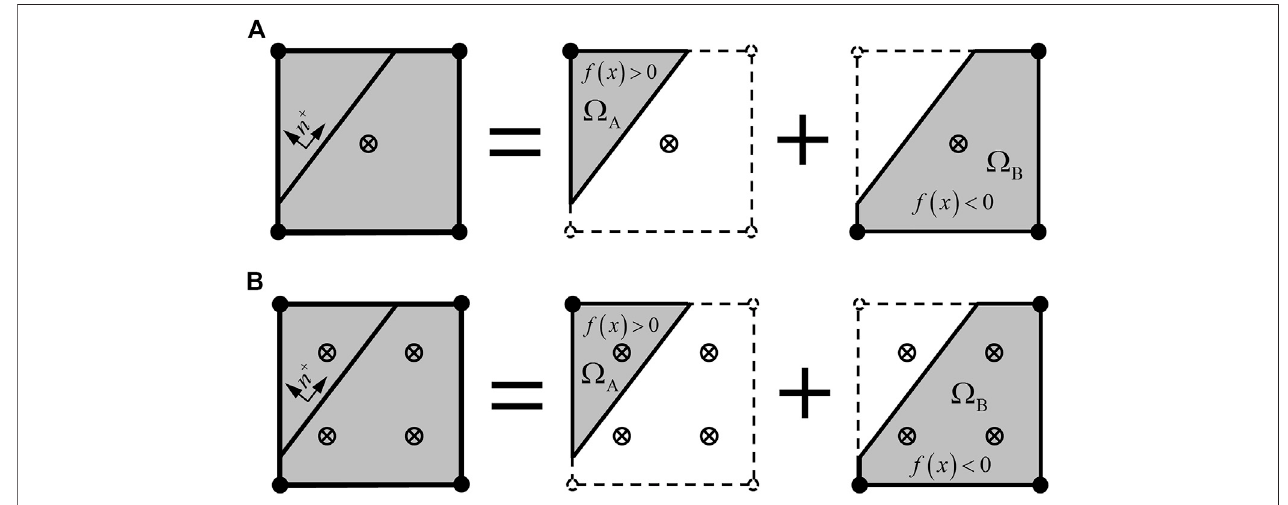
FIGURE2| Diagramofintegrationofelementcutbyadiscontinuousinterface(witha2-Dquadrilateralelementasanexample). (A) Integrationmethodproposedby Song et al. (2006). (B) Smeared integration method.